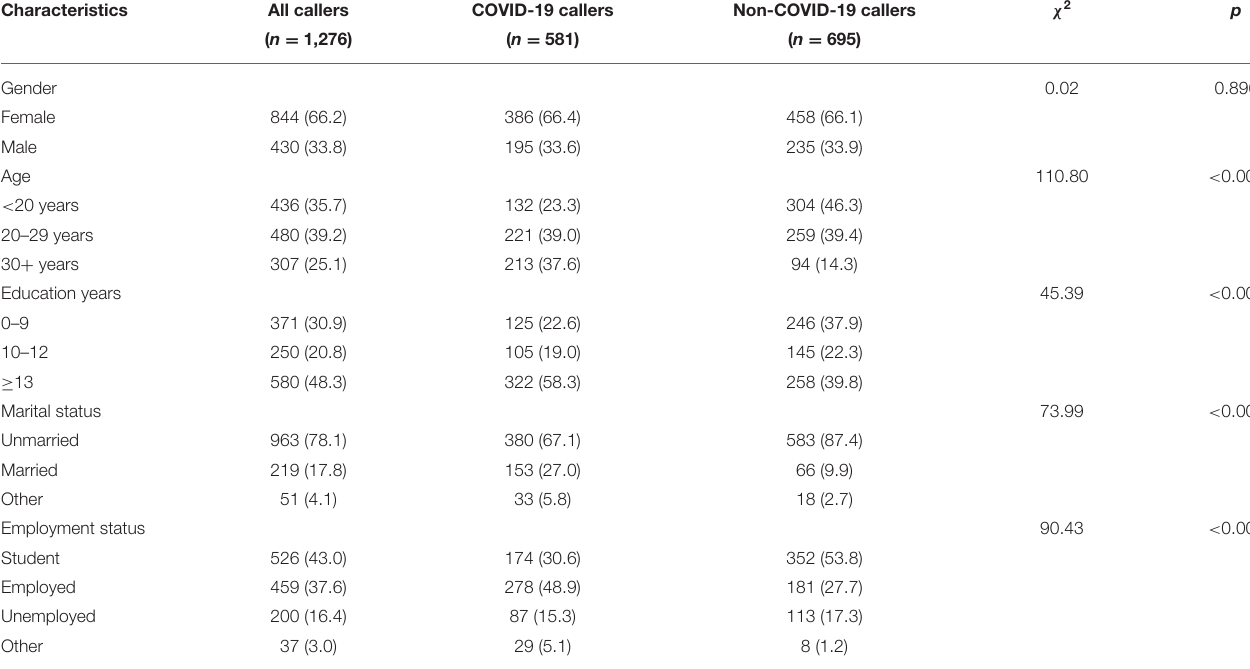
TABLE 1 | Comparison of characteristics of COVID-19 callers and non-COVID-19 callers [ n (%)]. Characteristics